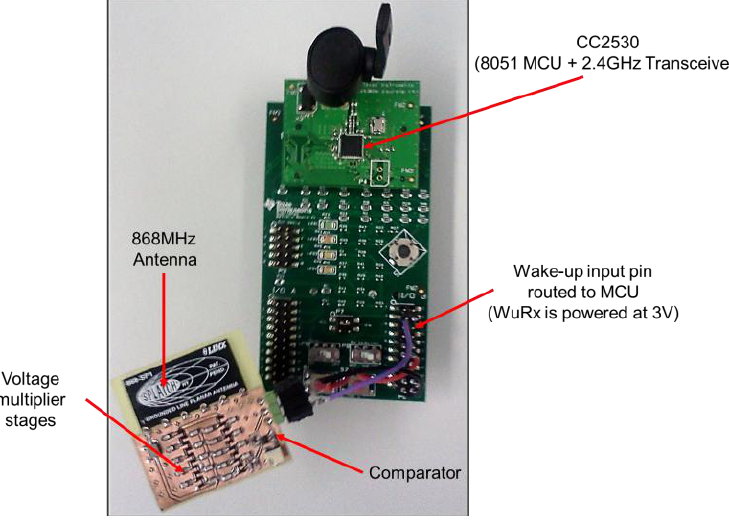
Figure 18. The low-complexity WuRx in [6] attached to a wireless sensor node. When the WuRx detects a WuC, the main board is woken up from sleep mode to transmit back an IEEE 802.15.4 data